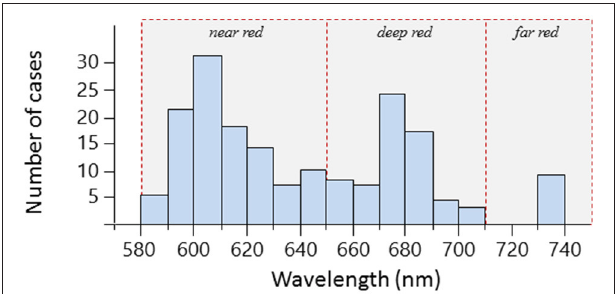
FIGURE 6 | Frequency distributions of peak emission wavelengths ( λ max ) for 114 fish species. Single species have between one and four emission peaks and can thus be represented multiple times. Hatched red lines delineate our categorization according to peak emission wavelength into near red, deep red, and far red